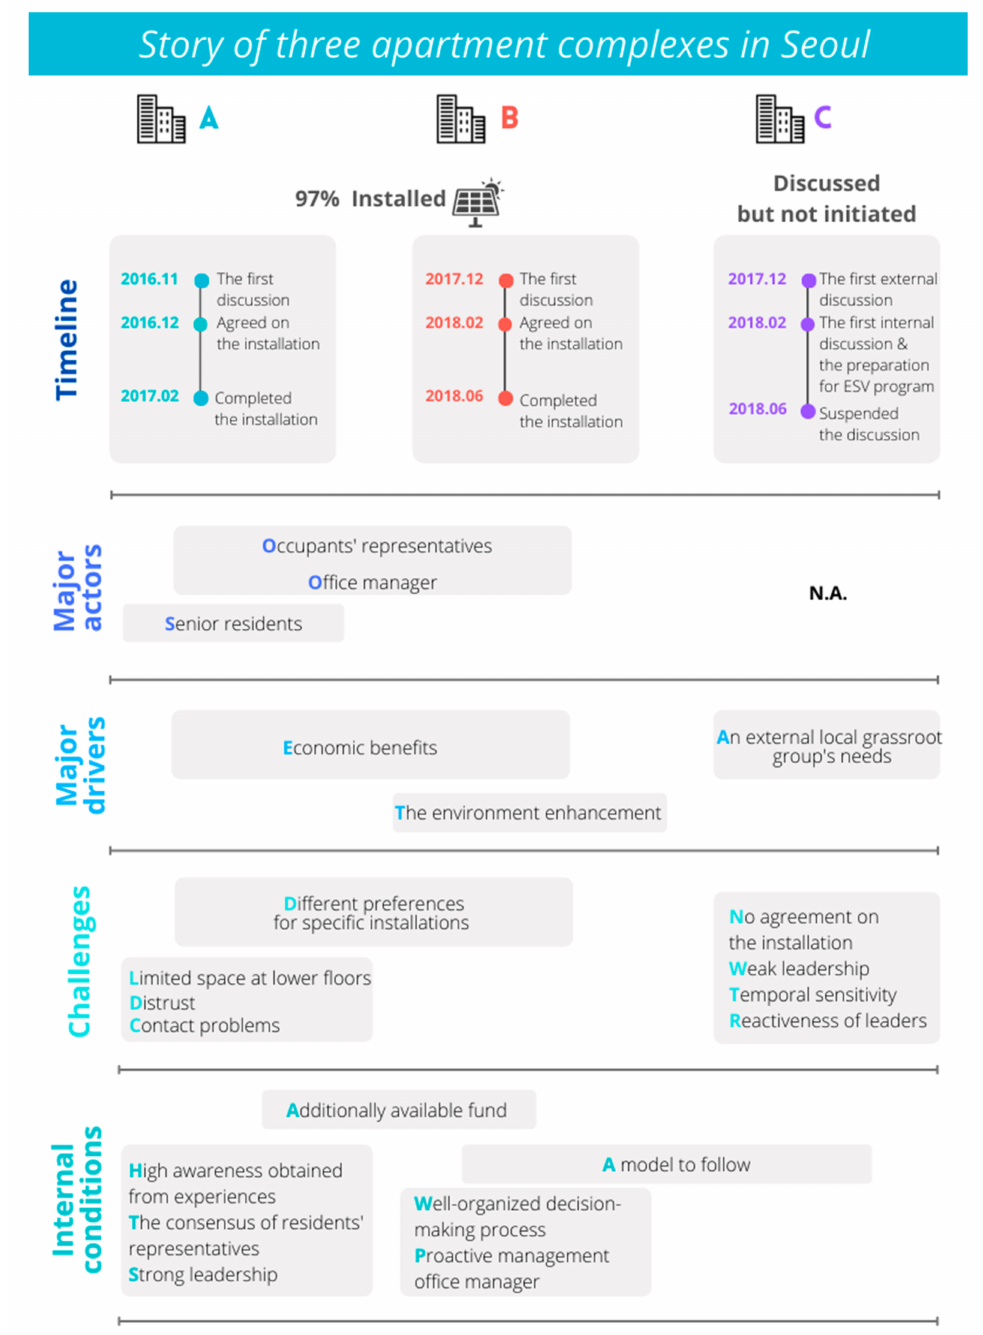
Figure 3. Snapshot of the collective mini-PV installation